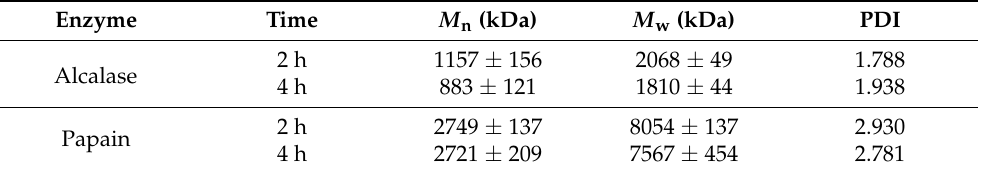
Table 8. Molecular weight (kDa) of hydrolysates of salmon skin after gelatin extraction shown in Figure S2; M w : weight average molecular weight; M n : number average molecular weight; and PDI: polydispersity index. Values are represented as the mean ± standard deviations ( n = 2). Enzyme Time M n (kDa) M w (kDa) PDI Alcalase